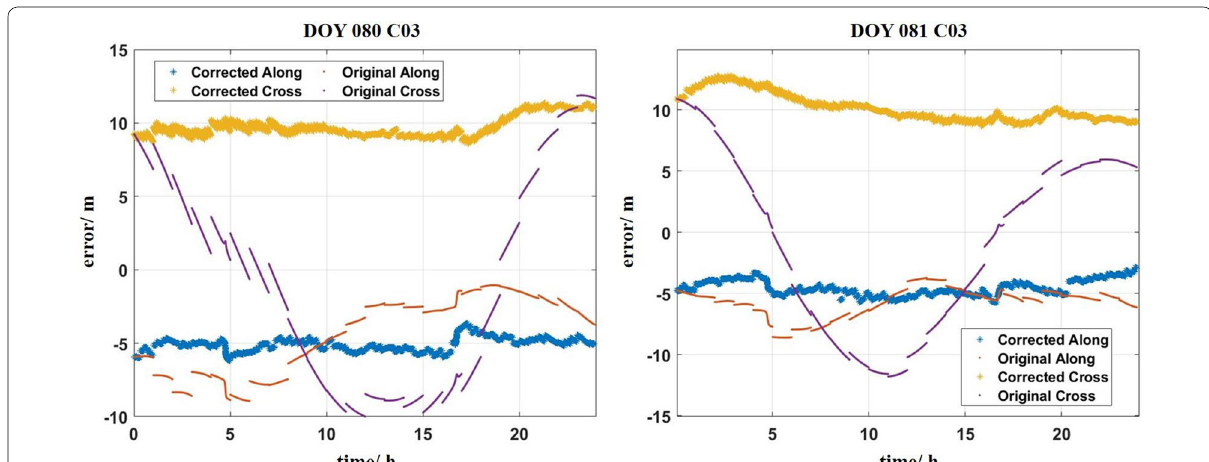
Fig. 5 Orbit fluctuation corrected results of C03 in DOY 080 (left) and DOY 081